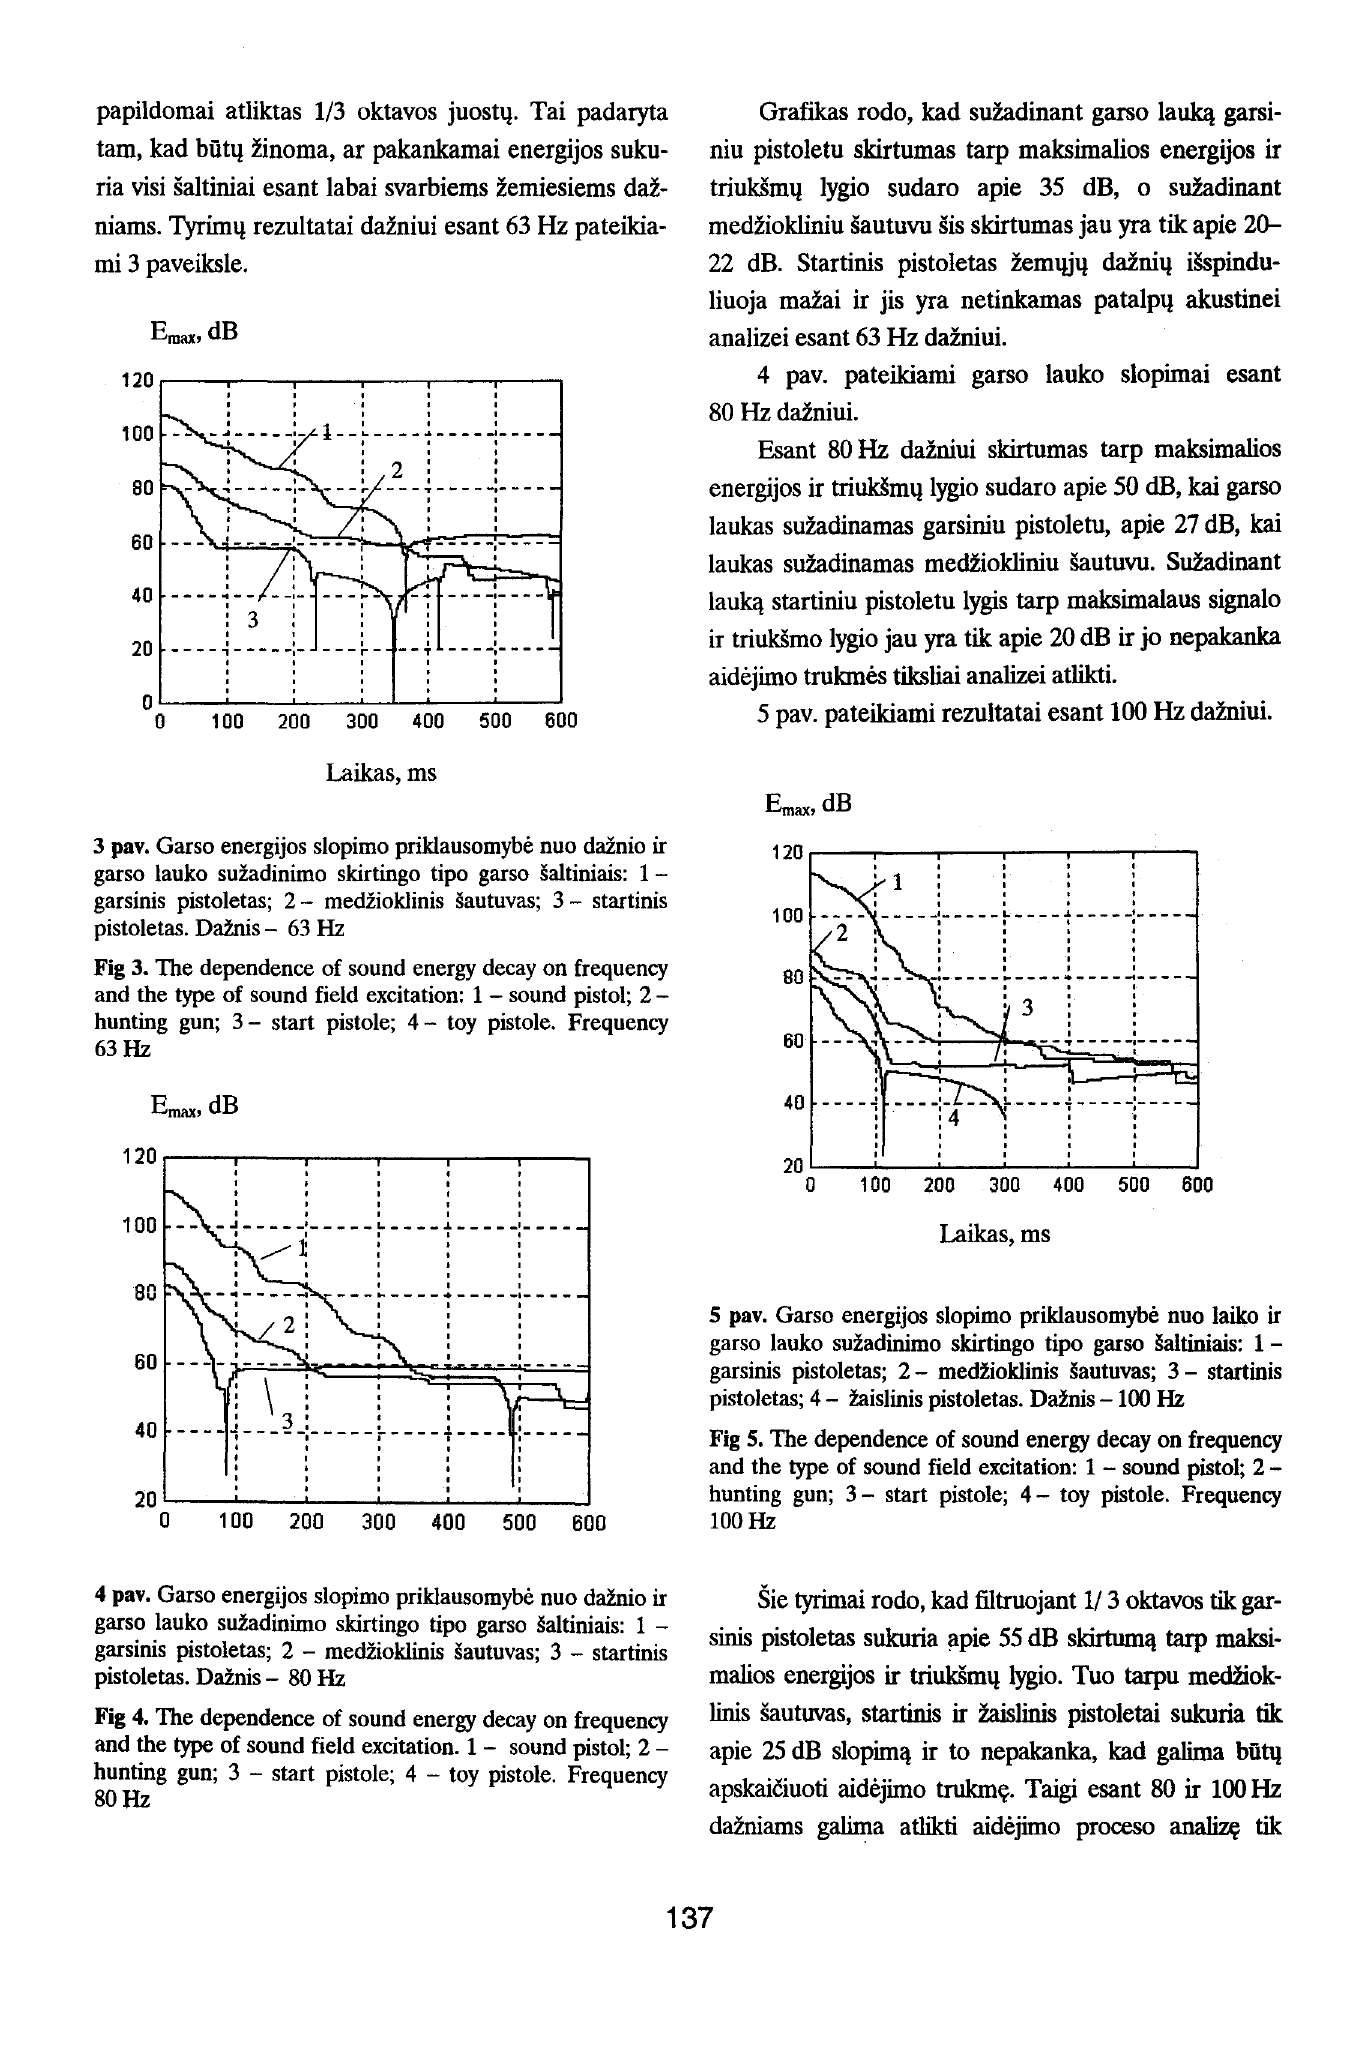
garsinis pistoletas; 2 - medZioklinis sautuvas; 3 - startinis pistoletas. Dainis - 80 Hz Fig 4. The dependence of sound energy decay on frequency and the type of sound field excitation. 1 - sound pistol; 2 - hunting gun; 3 - start pistole; 4 - toy pistole. Frequency